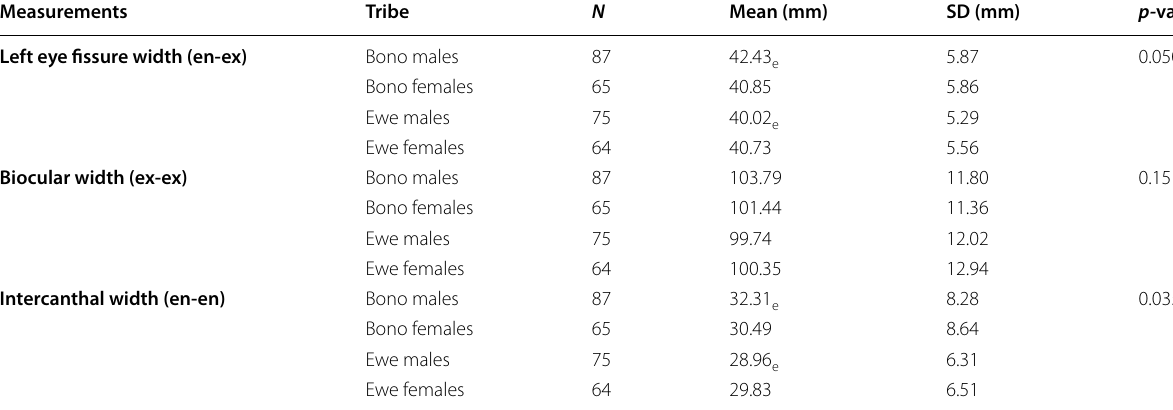
Table 6 Analysis of variance of ocular measurements stratified by tribe